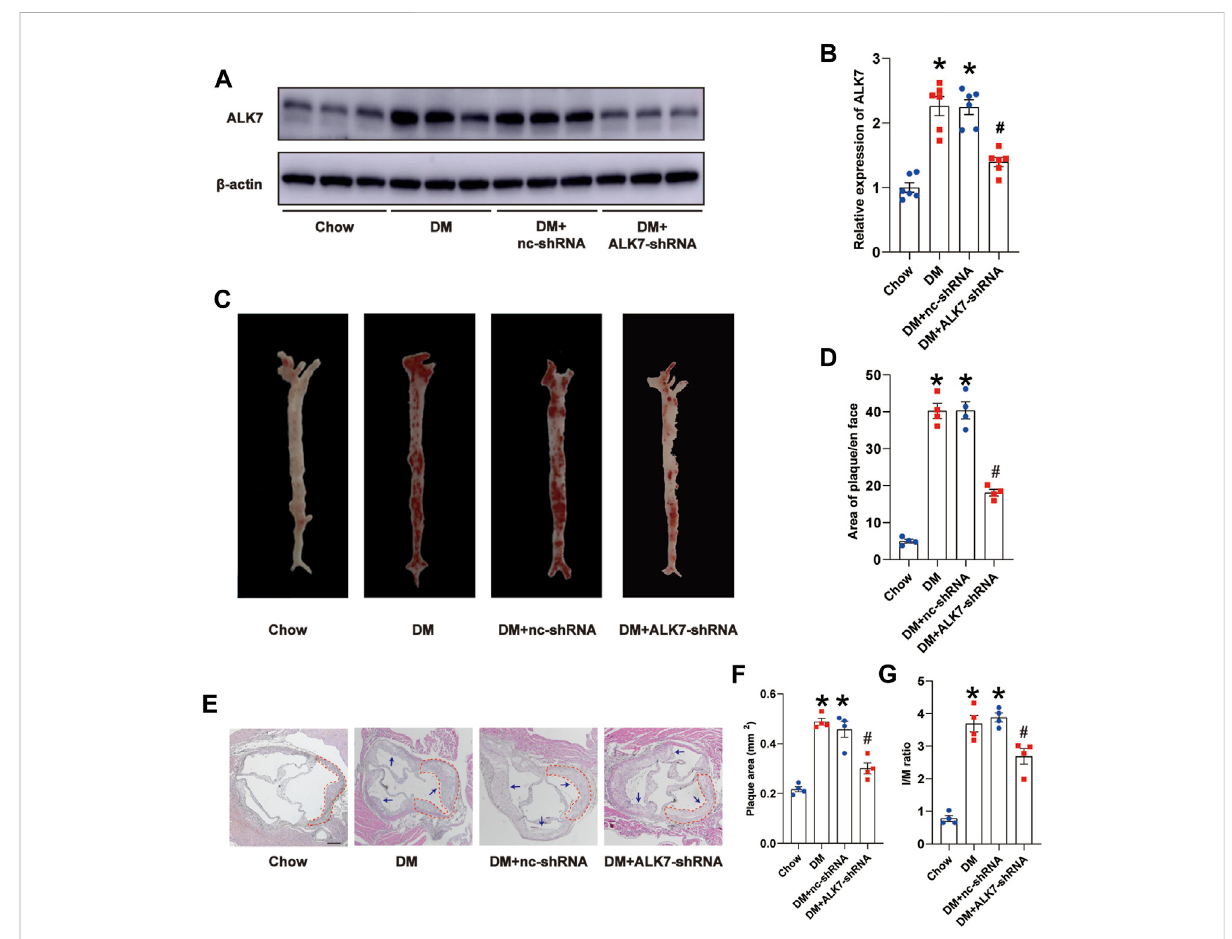
Knockdown of ALK7 reduced atherosclerotic plaque burden of diabetic mice. (A – B) . ALK7-shRNA lentivirus was delivered via tail vein and the protein level of ALK7 in the aorta was determined by western blot. n = 6 per group. (C – D) . Representative gross images of atherosclerotic plaques along the aortic trees was examined by the Oil Red O staining. n = 4 per group. (E – G) . Representative morphological images of aorta roots were stainedwithhematoxylinandeosin,andtheplaqueareaandI/Mratiowascalculated. n =4pergroup.Scalebar:100 μ m.Dashedlinesencircled some part of atheroscleroticplaque. Arrows indicated all theatherosclerotic plaques in theaorticroot. Data was analyzed with ANOVA. * p < 0.05 vs. the Chow group, # p < 0.05 vs. the DM + nc-shRNA